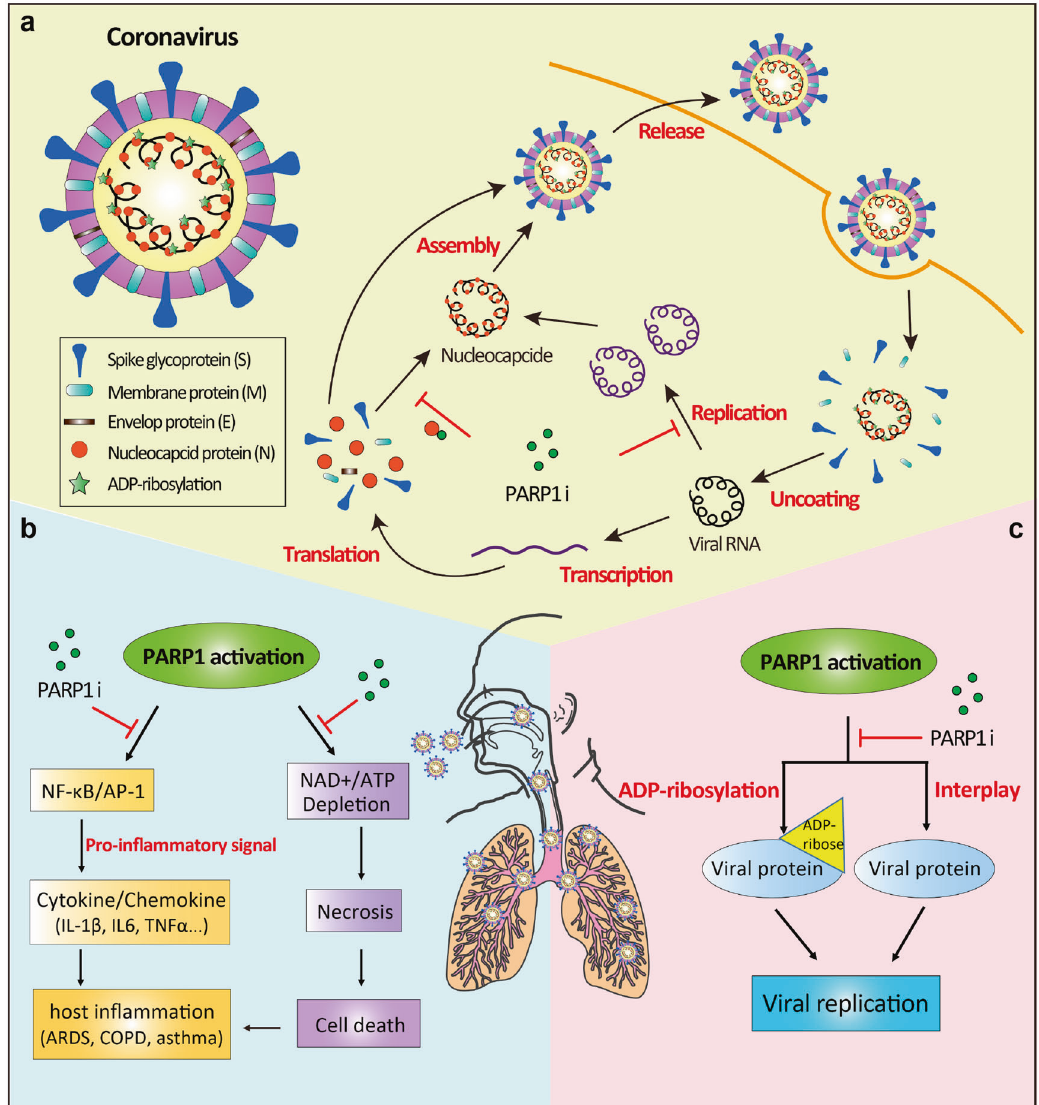
antiviral mechanisms of PARP1 inhibitors in the life cycle of coronavirus in human cells. PARP1 inhibitors have been previously reported in the literature to suppress viral replication and imped the binding of nucleocapsid protein to viral RNAs, thus preventing the virus infection. 47 – 50 b Potential protective effects of PARP1 inhibitors in the treatment of COVID-19. The anti-in fl ammation effects of PARP1 inhibitors may be achieved through two possible molecular pathways. The fi rst one is to modulate the expression of pro-in fl ammation factors such as NF- κ B, AP- 1, IL-6 and downstream cytokines and chemokines. 51 – 54 The second possible pathway is to prevent the overactivation of PARP1 and thus avoid the depletion of NAD + and ATP, and the consequent cellular energy failure and cell death caused by necrosis. 51 – 54 c The